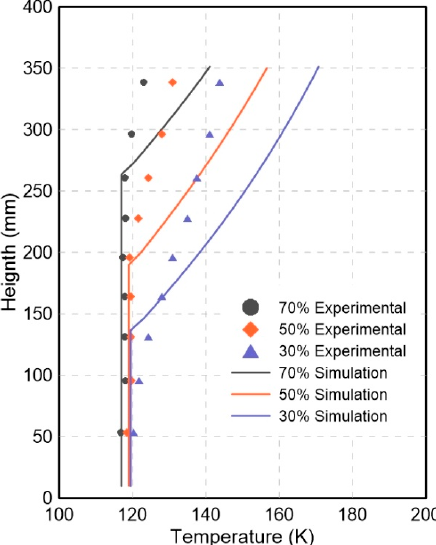
Figure 11. Comparison between experiments and numerical analysis for vertical temperature profile.